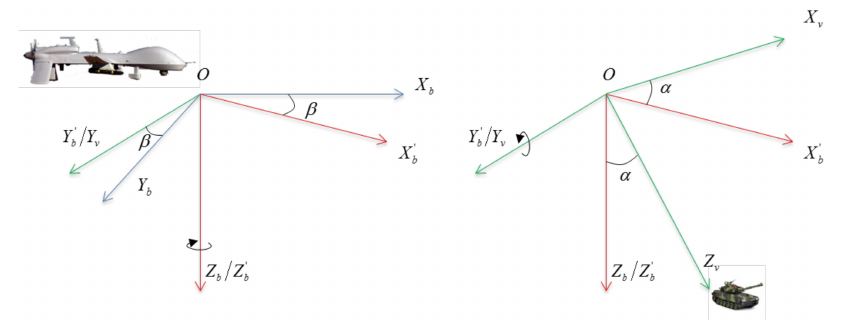
Figure 3. The imaging coordinate frame and aircraft coordinate